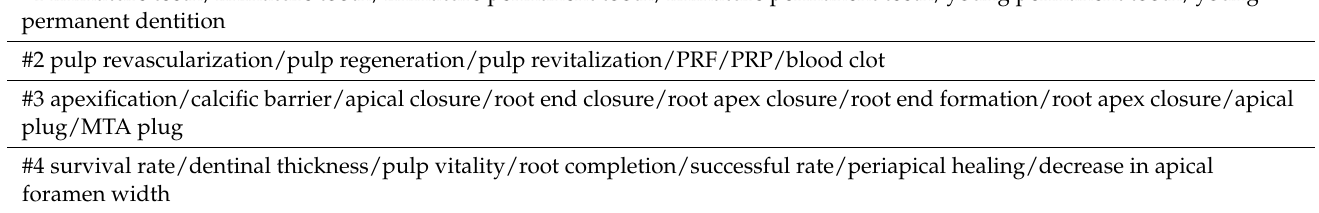
Table 1. Search strategy.